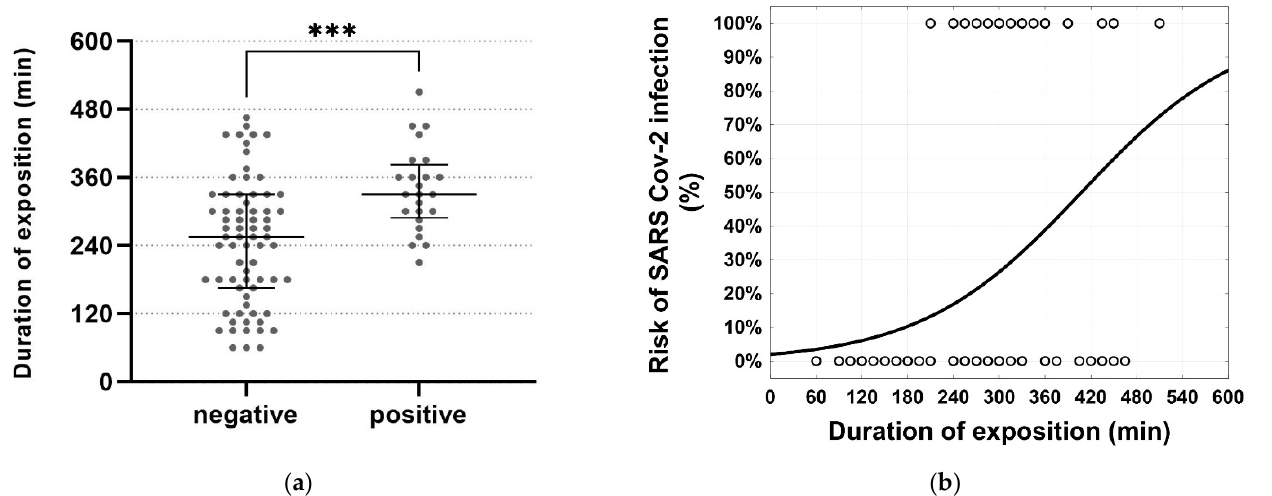
Figure 4. ( a ) Scatter dot plot of the time spent at the event in relation to a positive or negative test. The longer middle lines within the plots represent the median, the shorter lines within the plots bracket the interquartile ranges. Statistical analysis by t-test, two-sided, *** represents p ≤ 0.0002. ( b ) Calculated risk of infection relative to the duration of stay at the event.